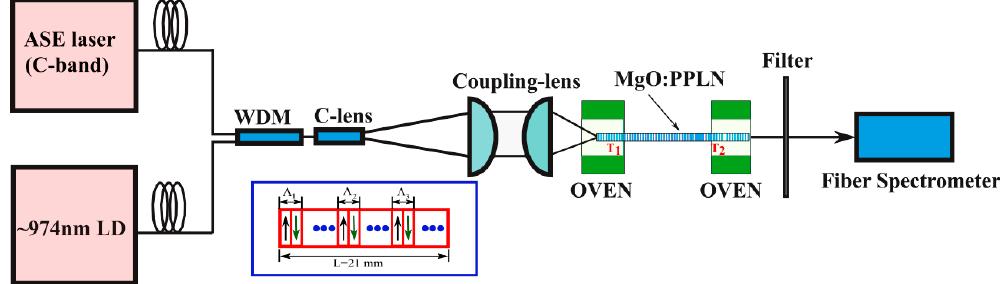
Figure 1. Schematic of the experimental setup. The beams are focused into single-pass MgO:PPLN to produce orange light by sum frequency generation (SFG). LD, laser diode, ASE: amplified spontaneous emission, WDM: wave division multiplexer; C-lens: collimator lens. Inset: close view of crystal gratings with different sections.